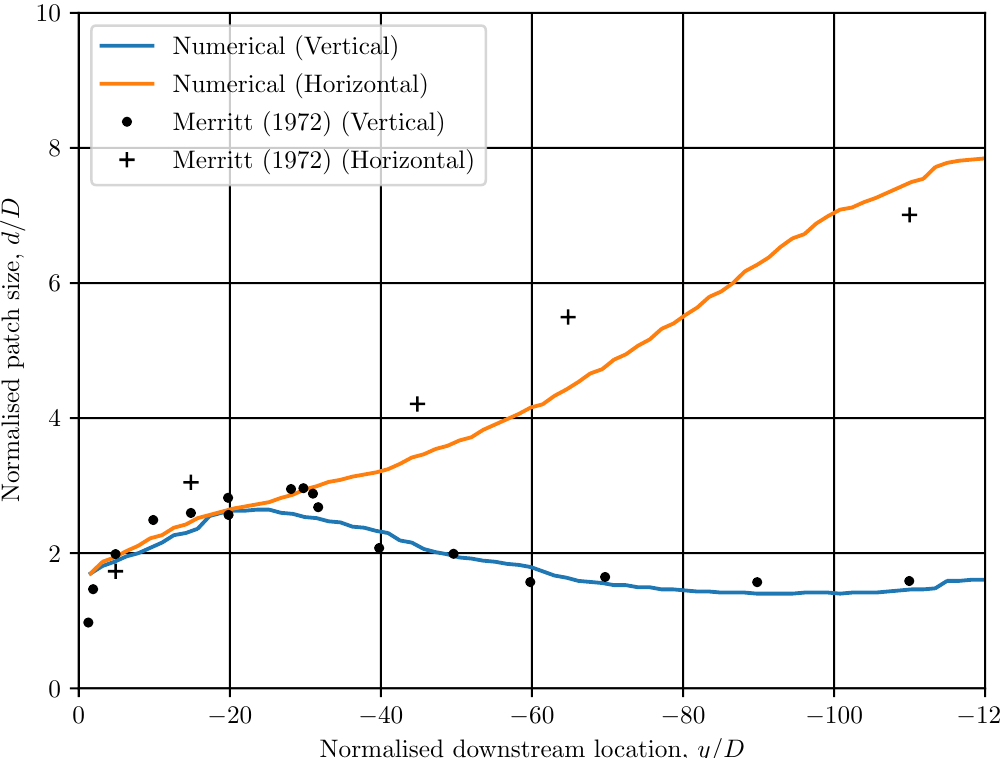
Figure 5. The evolution of the height and width of the mixed patch downstream of the propeller. All quantities are normalised by the patch’s initial diameter. For the numerical results this is assumed to be equal to the diameter of the propeller, D . Data from an analogous experiment by Merritt [4] are included for